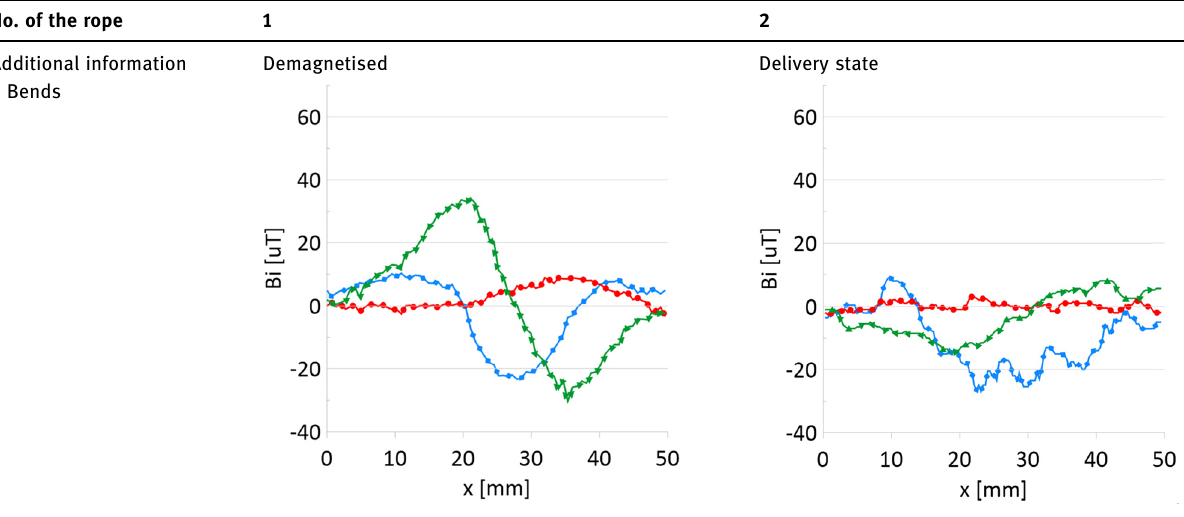
Table 2: Results - ropes no. 1 and